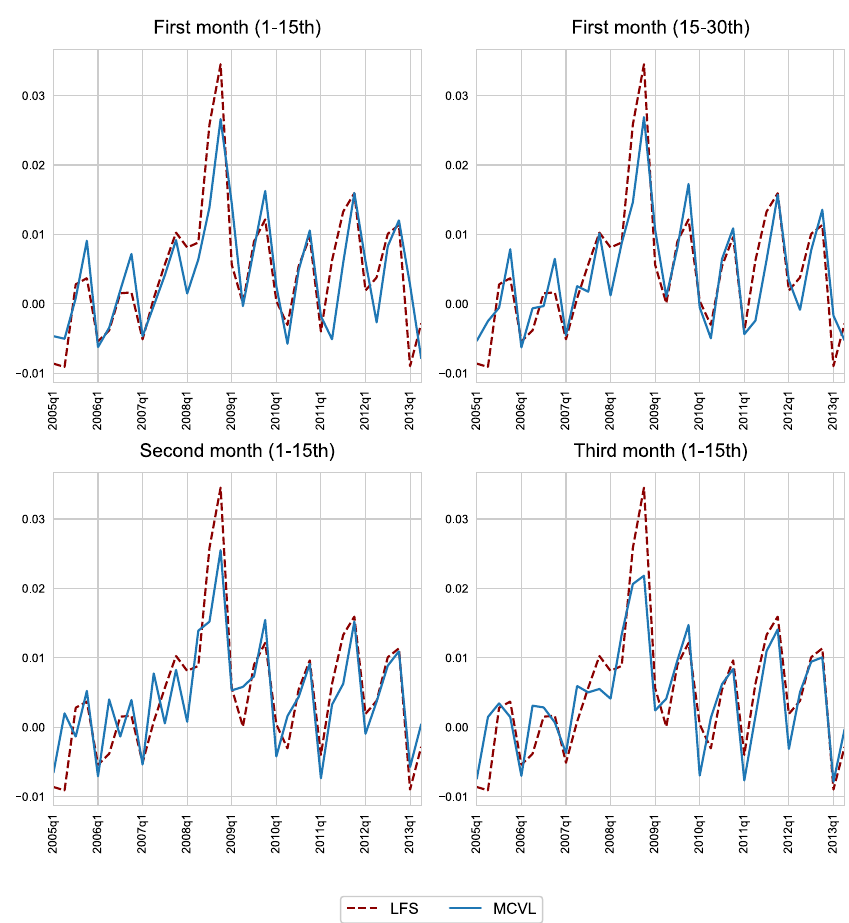
Fig. 27 Seasonality of unemployment by reference week, LTU